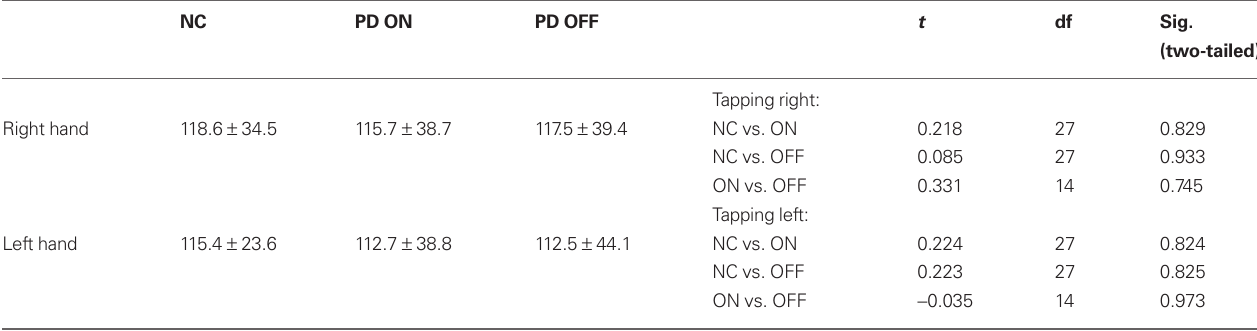
Table 7 | Means and standard deviations for the number of taps in the finger-tapping task for normal controls (NC) and PD patients.